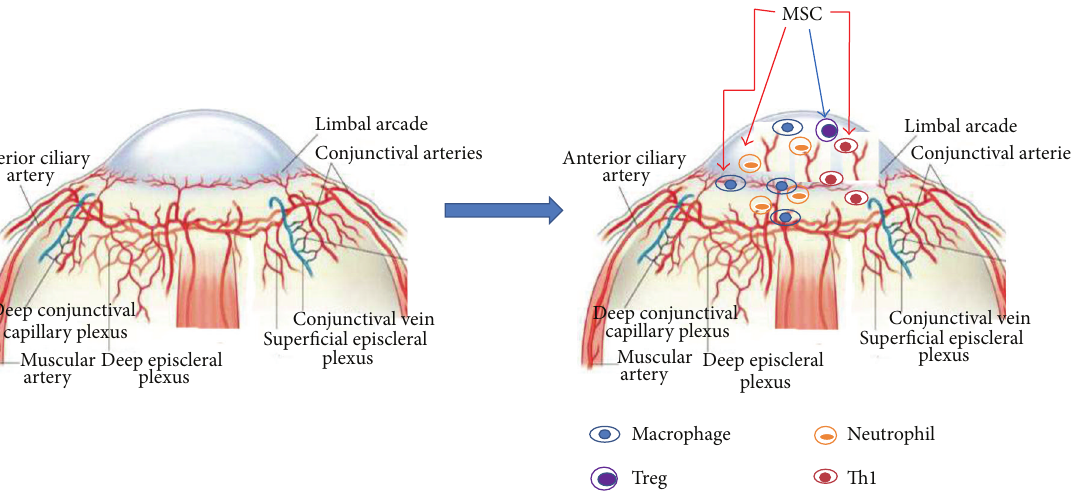
Figure 1: Modulation of immune cells and inflammatory cells by MSCs in corneal surface diseases. Cornea is the avascular and transparent front part of the eye, maintained by immune and angiogenesis privilege. In the occurrence of injury and transplantation, ingrowth of blood and lymph vessels into the cornea leads to infiltration of inflammatory cells and Th1 cells, which strengthen the inflammation and damage the cornea structure. MSCs have several protective functions by (1) inhibition of the inflammatory cell infiltration and inflammatory cytokine release, (2) activation of Treg cells for immune tolerance, (3) tuning the transition from Th1 cells toward Th2 cells, and (4) improving epithelium regeneration (not